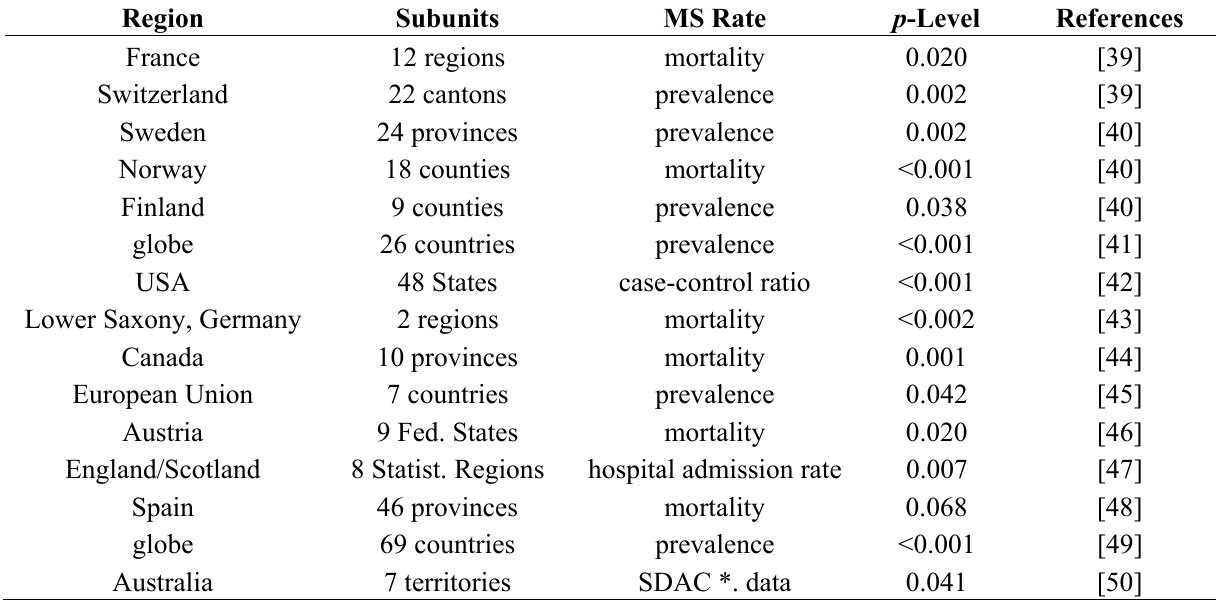
Table 1. Correlation of MS prevalence, or MS mortality, with processed, or smoked, meat intake, favouring a pathogenetic role, in 14 regions. * SDAC: Survey of Disability, Ageing and Carers of the Australian Bureau of Statistics, 2009. Spearman’s coefficient or Mann-Whitney test were